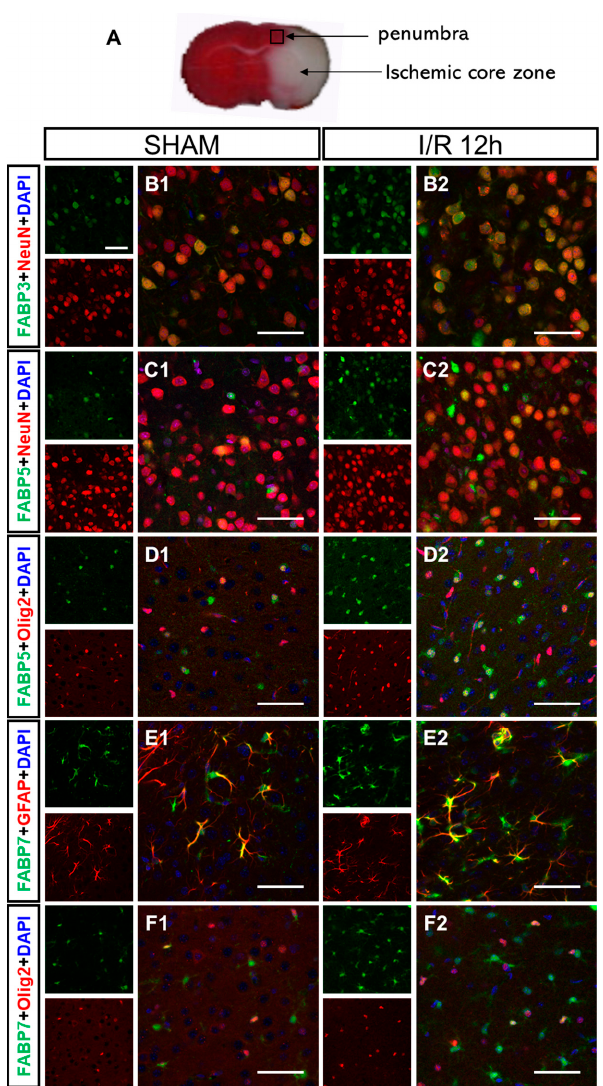
Figure 5. Immunofluorescence of FABP3, FABP5 and FABP7 in the cortexes of sham and I/R mice. ( A ) Representative micro-graphs of immunofluorescence staining of the cortical penumbra region (shown in the black box area) at 12 h after reperfusion. ( B ) Double staining for FABP3 (green) and NeuN (a neuronal marker, red) expression in sham mice ( B1 ) and I/R mice ( B2 , ipsilateral). ( C , D ) Double staining for FABP5 (green) and NeuN (red; C ) or Olig2 (an oligodendrocyte marker, red; D ) in sham mice and I/R mice (ipsilateral). ( E , F ) Double staining for FABP7 (green) and GFAP (an as-trocyte marker, red; E ) or Olig2 (red; F ). Scale bar = 50 µ m. The two small images on the left show immunofluorescence for FABPs and cell markers, whereas the larger image on the right is a merged